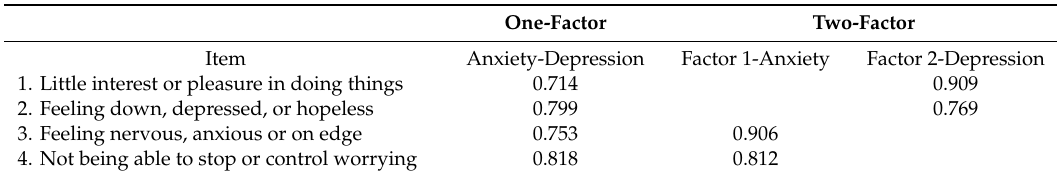
Table 3. One-factor and two-factor solution matrix of confirmatory factor analysis with varimax rotation for the PHQ-4 during pregnancy.